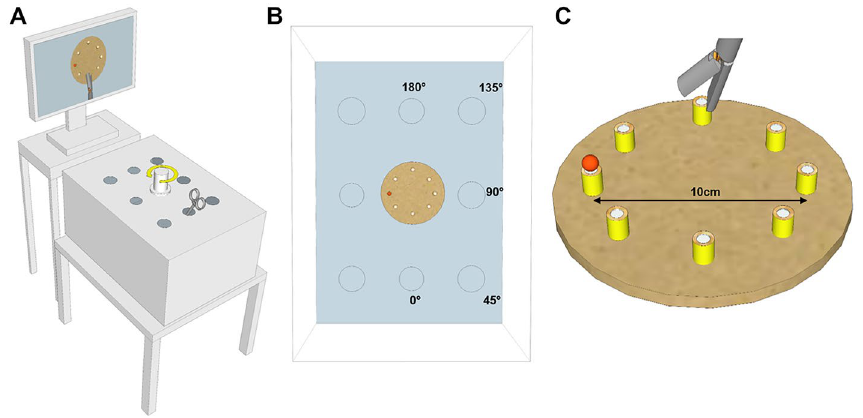
Figure 1. ( A ) Schematic of box trainer with custom adjustable camera mount used in the experiment. ( B ) Overhead view of the box trainer ports that were tested. Transparent walls are depicted for visualization purposes only and permit comparison of the port locations relative to the peg transfer task apparatus on the inner floor of the box trainer. ( C ) Close-up view of the peg transfer task